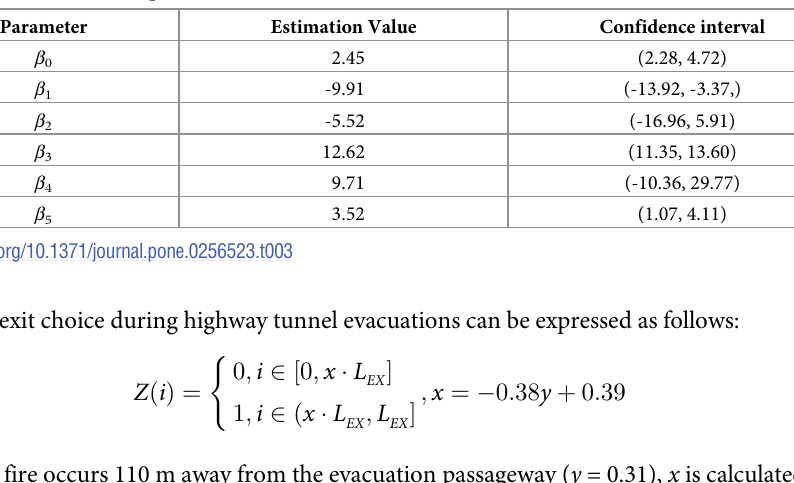
Table 3. The results of each parameter.